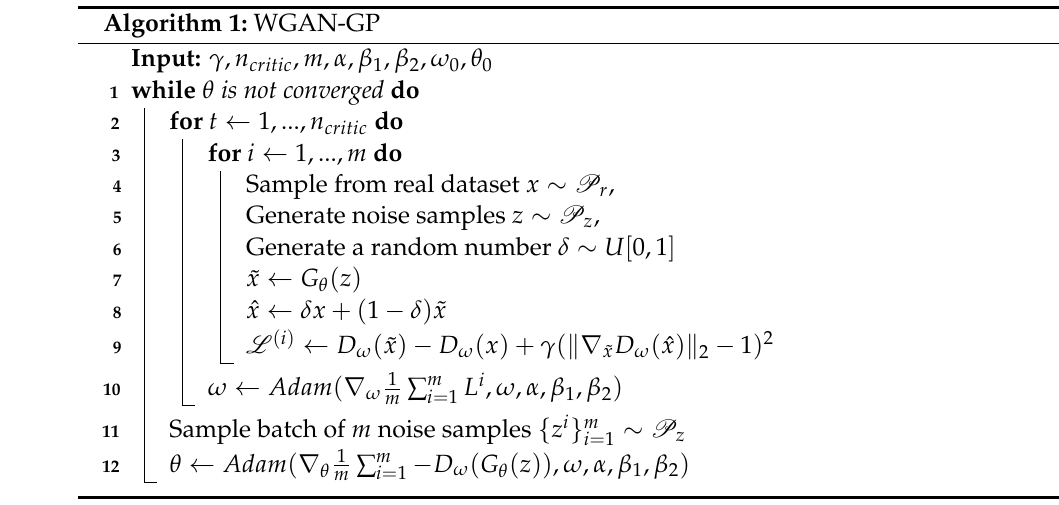
Figure 3. Schematic illustration of the proposed model for the training